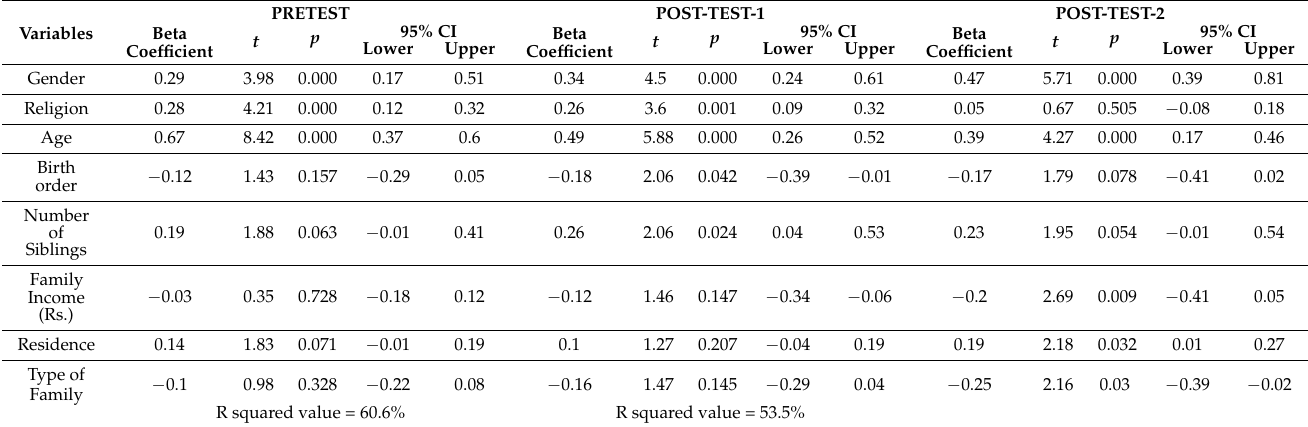
Table 5. Regression Model describing the Effect of BMI on Demographic Variables of Study group.